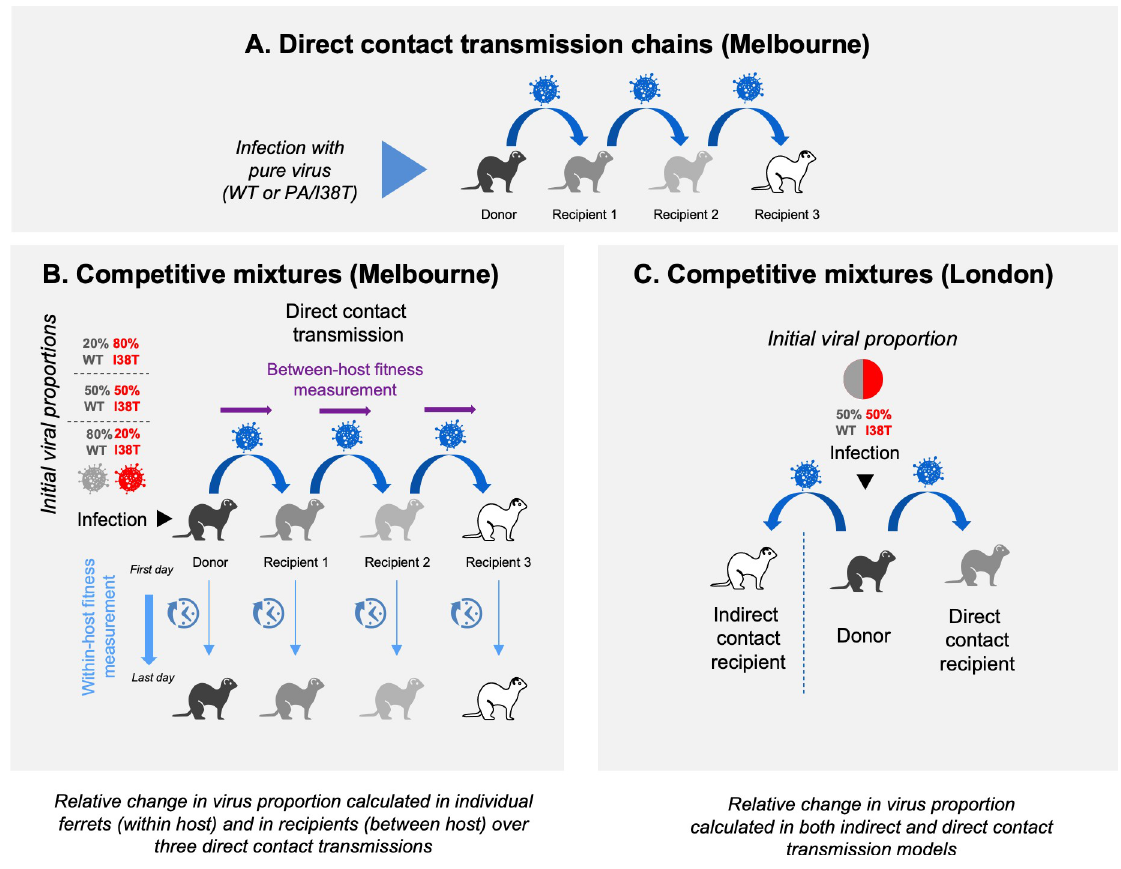
Fig 2. Experimental setups used for the ferret transmission experiments. (A). Direct contact transmission chains were used to examine fitness of pure WT or PA/I38T virus populations. (B and C) Donor ferrets are infected with different initial proportions of WT:I38T viruses in a direct contact model (B) or in both direct and indirect contact models (C). The relative change in virus proportions is calculated as indicated in the different models. WT, wild